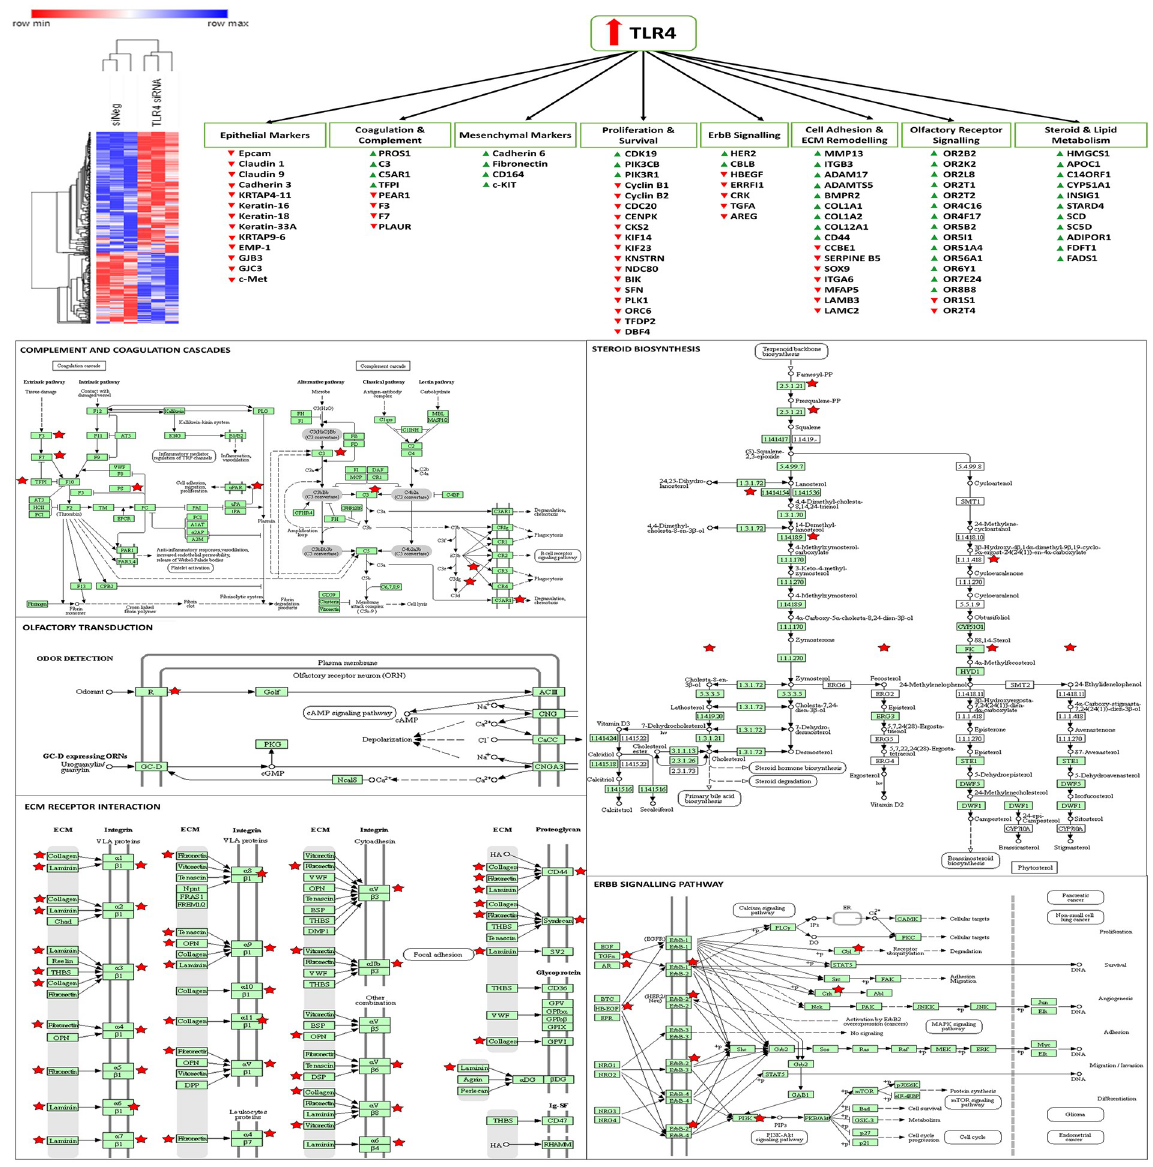
Fig 6. Altered genes and biological processes following knockdown of TLR4. Microarray analysis revealed that TLR4 controls genes related to EMT, survival and proliferation, steroid and lipid metabolism, olfactory receptor signalling, adhesion, coagulation and complement cascades, and ErbB signalling. A hierarchial clustering heatmap was generated using Morpheus from the broad institute. KEGG pathway maps were generated using DAVID, red stars indicate genes significantly altered in the TLR4 knockdown microarray data set.